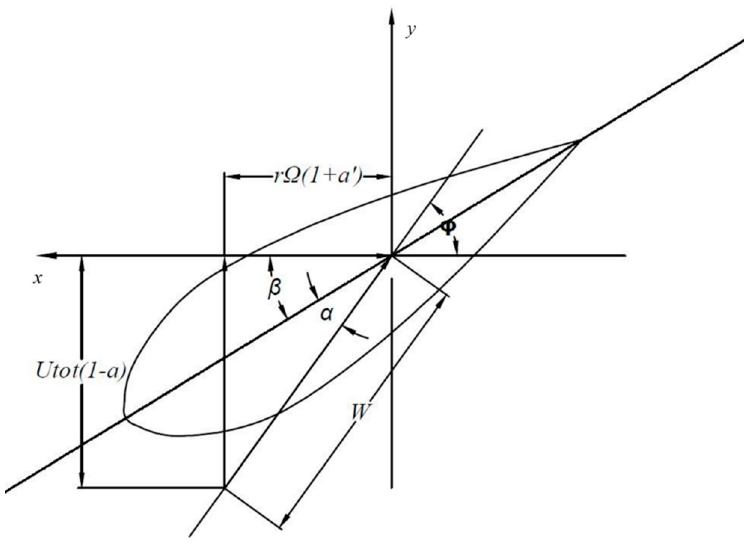
Figure A1. Blade Element velocity components.